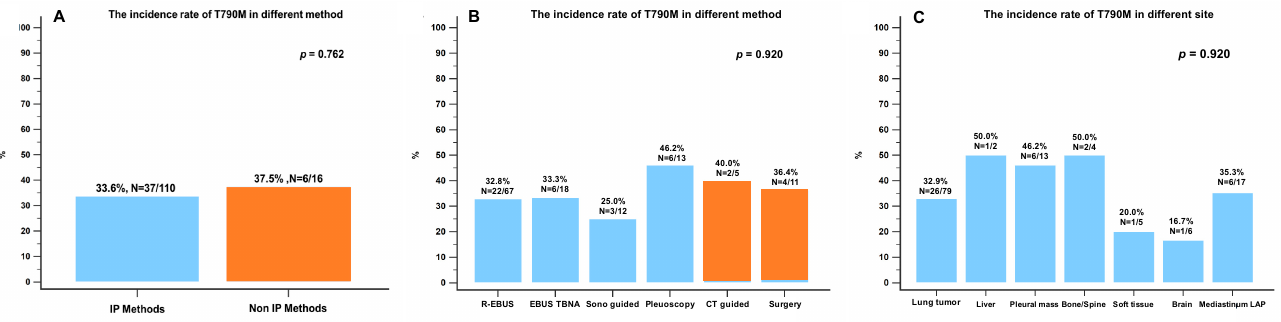
Figure 5. ( A ) The rate of incidence of the T790M mutation detected by all IP and all non-IP methods. ( B ) The rate of incidence of the T790M mutation detected by different IP and non-IP biopsy methods. ( C ) The rate of incidence of the T790M mutation rate in different biopsy sites. CT: computed tomogra- phy; IP: interventional pulmonology; LAP: lymphadenopathy; R-EBUS: radial probe endobronchial ultrasound; TBNA: transbronchial needle aspiration.